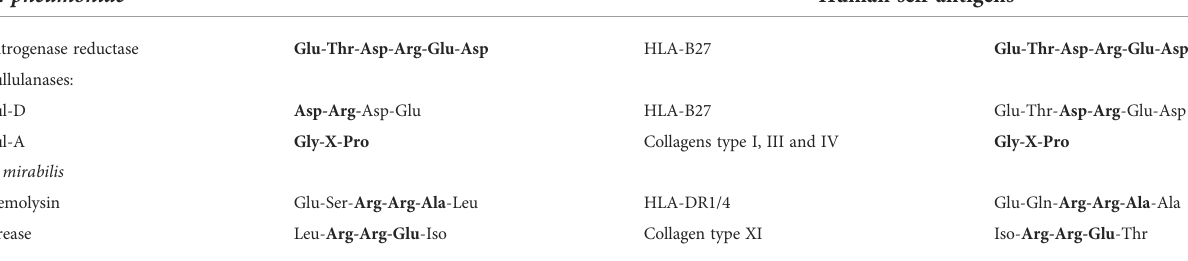
TABLE 1 Molecular similarities between human self-antigens and appropriate P. mirabilis and K. pneumoniae enzymes (Schwimmbeck et al., 1987; Ebringer et al., 1992; Fielder et al., 1995; Wilson et al., 1995; Ebringer et al., 2003; Ebringer et al., 2006; Rashid and Ebringer, 2007a; Rashid and Ebringer, 2007b; Konieczna et al.,